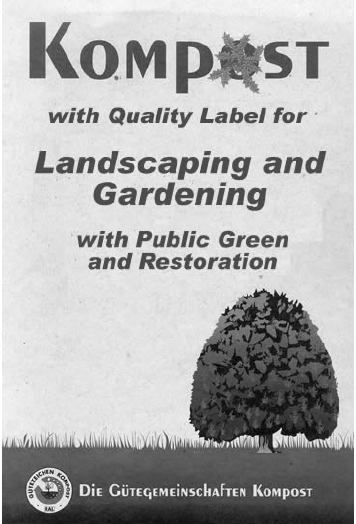
Figure 13: German compost specifications for